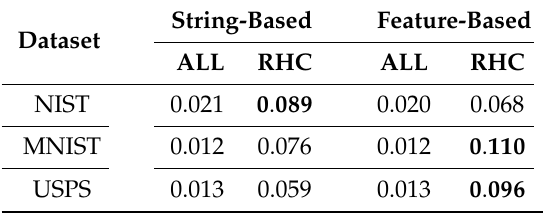
Table 3. Results in term of the estimated profit per prototype metric. All values have been scaled up two orders of magnitude for simplifying the comparison. Bold values represent the best overall profit for each corpus. All results report deviation values lower than